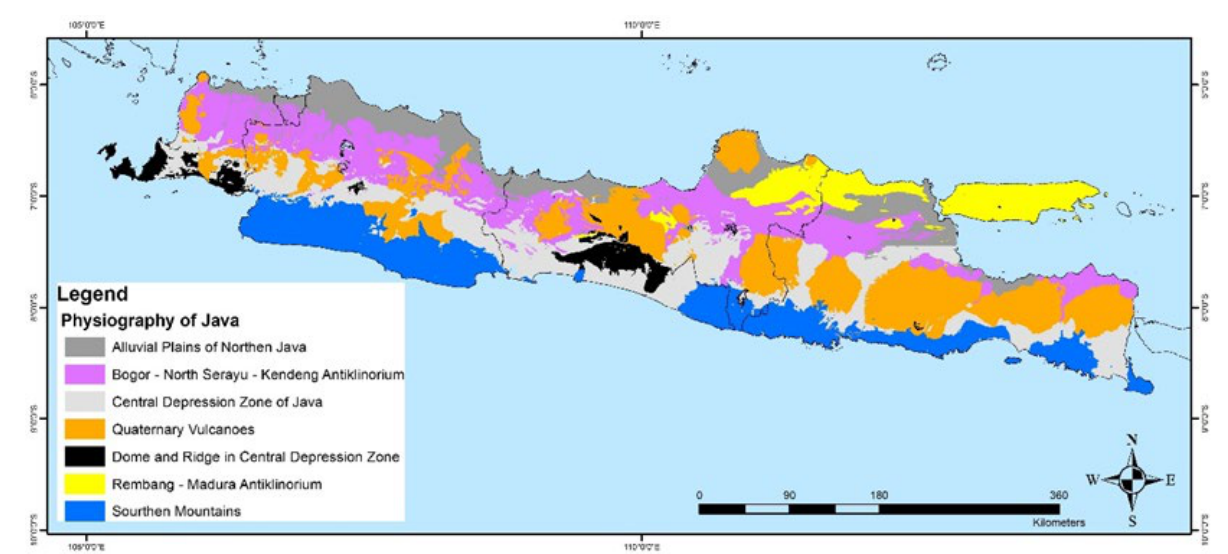
Figure 2. Geological map of Java Island obtained from [24].